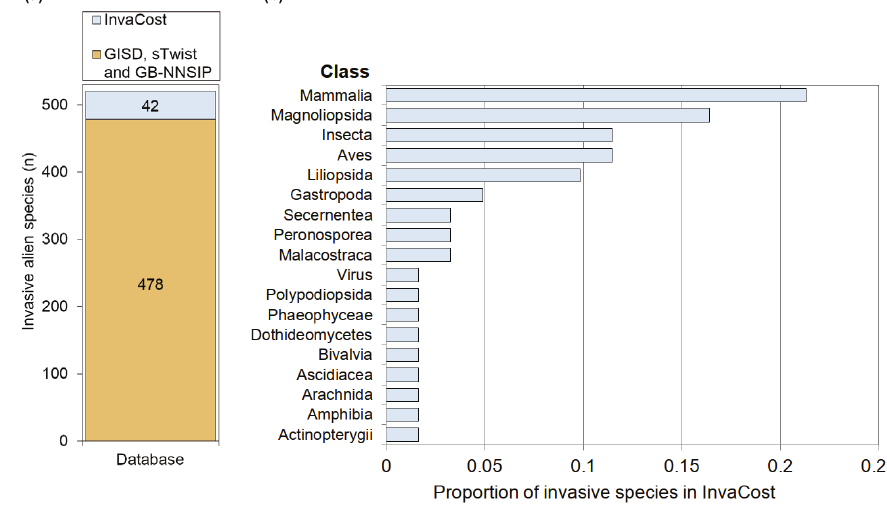
Figure 2. Barplots showing a total numbers of all known invasive species in the UK (i.e. species within GISD, sTwist and GB-NNSIP) and UK invasive species in InvaCost; and b proportions of UK invasive species in InvaCost across